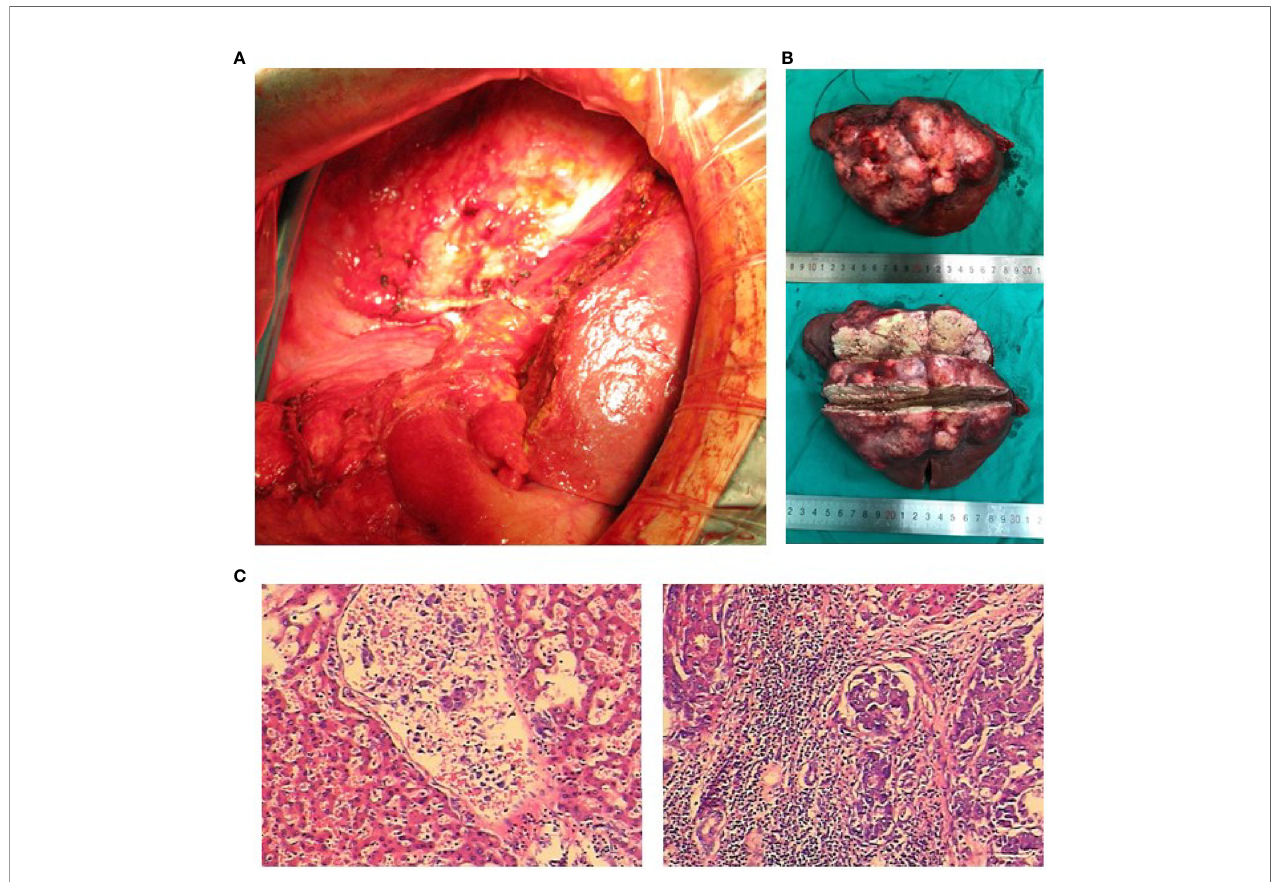
FIGURE 3 | Intraoperative photos, postoperative tumor section, and pathological examination. (A) Massive hepatocellular carcinoma (HCC). The liver was examined laparoscopically. (B) The resected specimen was a carcinoma with a large amount of necrotic tissue. (C) Pathological diagnosis: massive